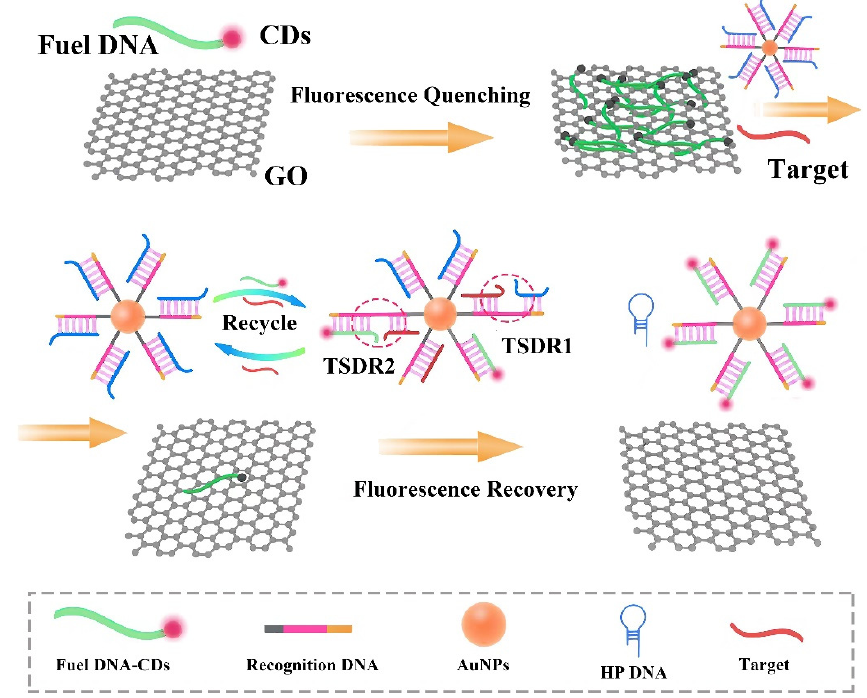
Figure 1. Schematic of nonenzymatic miRNA detection based on the CDs-labeled fluorescent probe and GO.